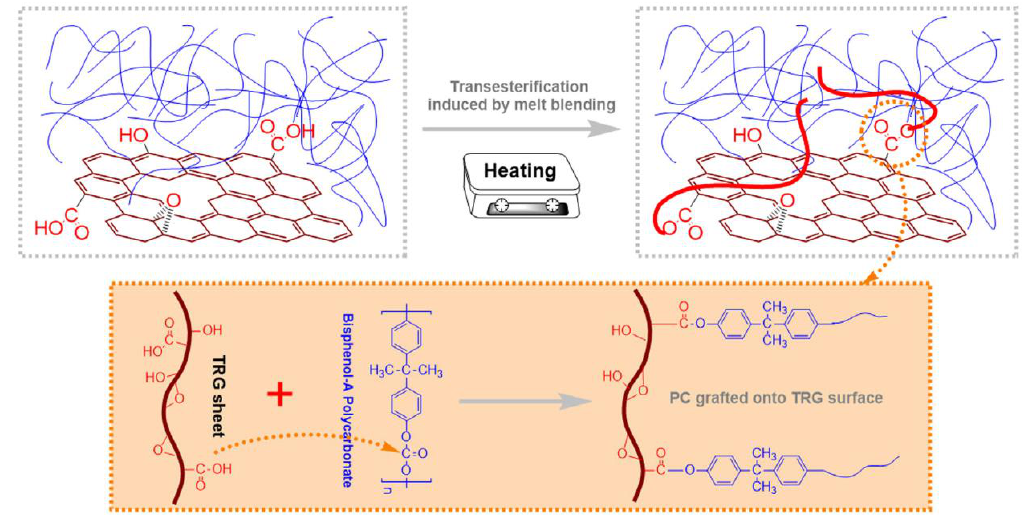
Figure 4. Schematic diagrams of the transesterification between the carbonate groups in PC chains and the carboxyl groups on thermally reduced graphene oxide (TRG) sheets at high temperature during melt-blending [79]. (Reproduced from [79] with permission; Copyright 2013 Elsevier).